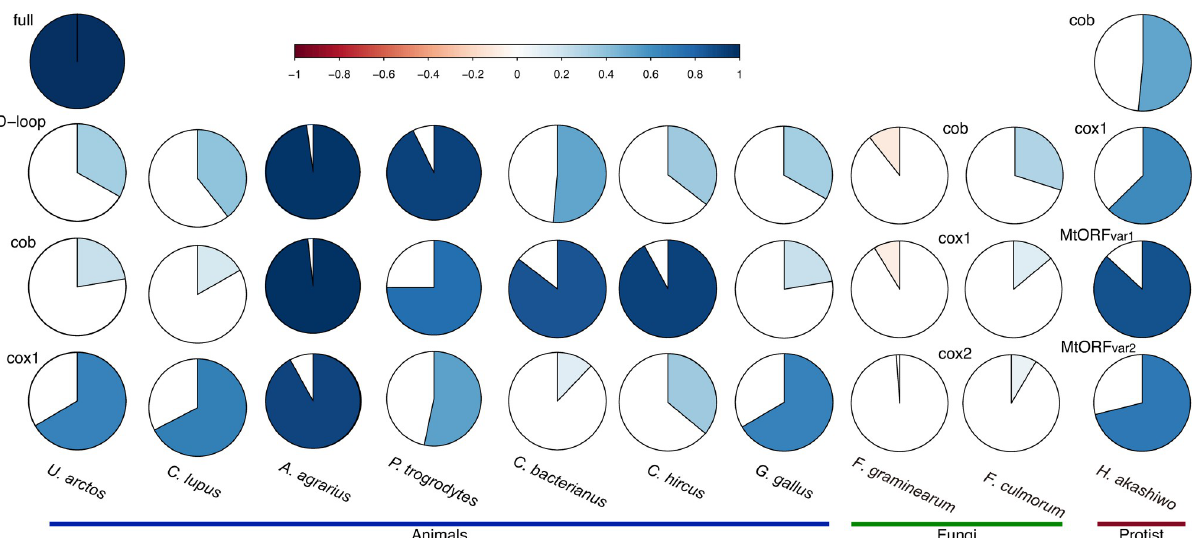
Fig 3. Correlations between the PRANK-aligned MSA-based phylogenies of full-length mtDNA sequences and those of indicated genes/segments on mtDNA. Note that a complete match between two data sets, for example, the correlation between the U . artcos full-length mtDNA dataset to itself, yields the rightmost top chart (full), and the extent of correlation and ratio of the correlated combinations to all tested combinations are expressed by color (top bar) and chart.